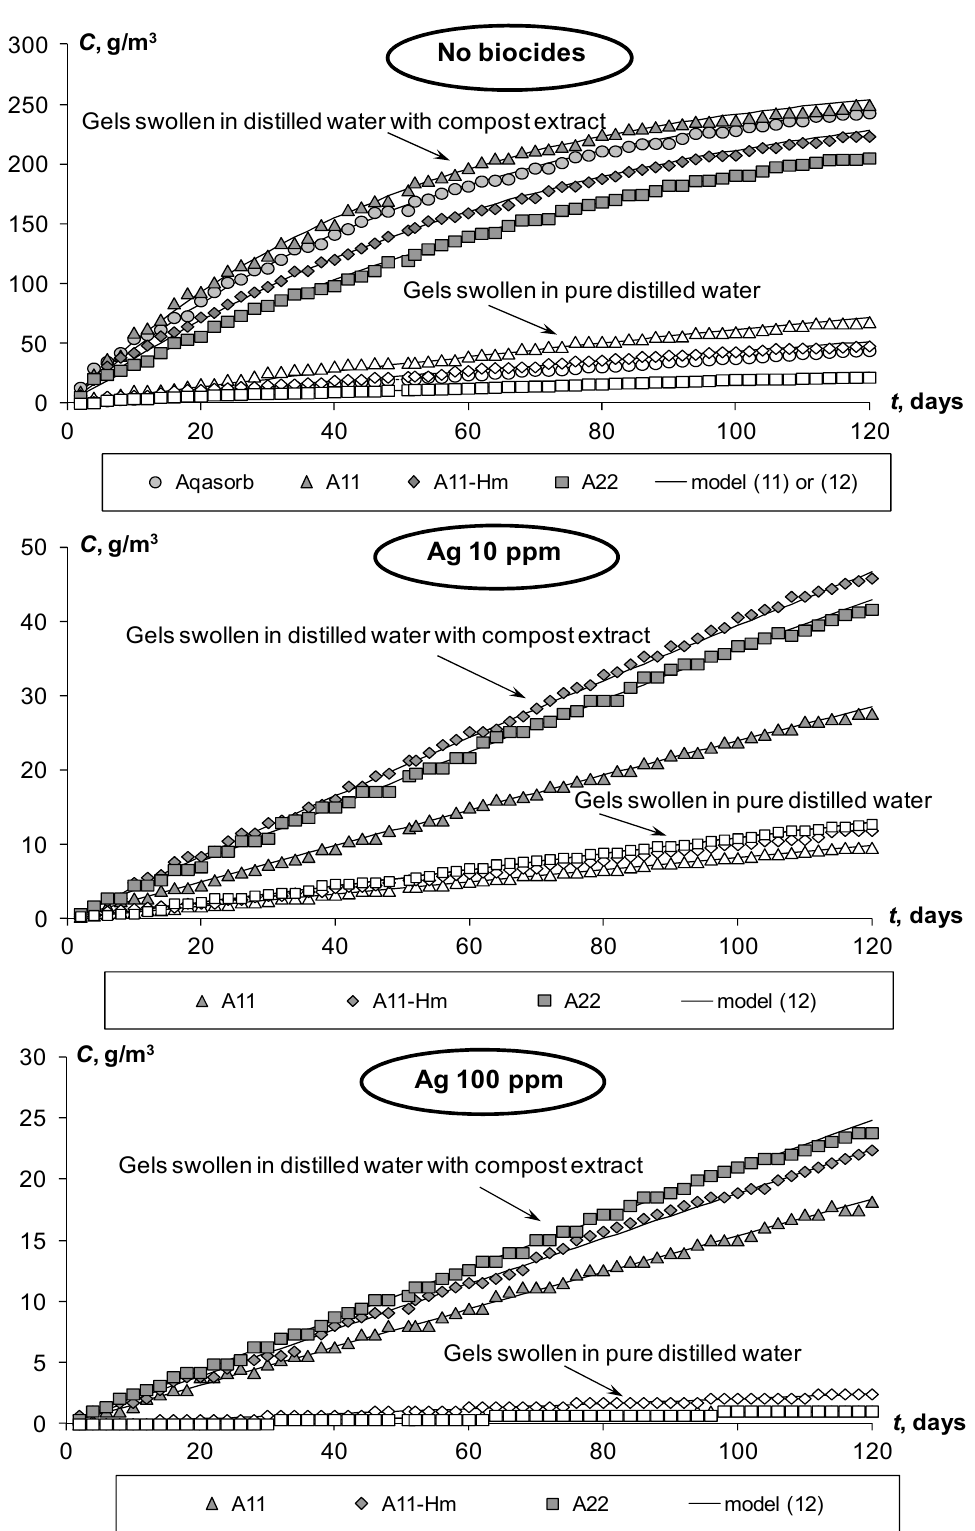
Figure 2. Respirometric oxygen uptake curves ( C ( t )) for various types of composite hydrogels and different incubation conditions (with and without compost extract). For the names of the gels, see “Objects and methods”. Ag 10 ppm, Ag 100 ppm are the concentrations of silver ions in gel structures at a swelling degree of 1:100.